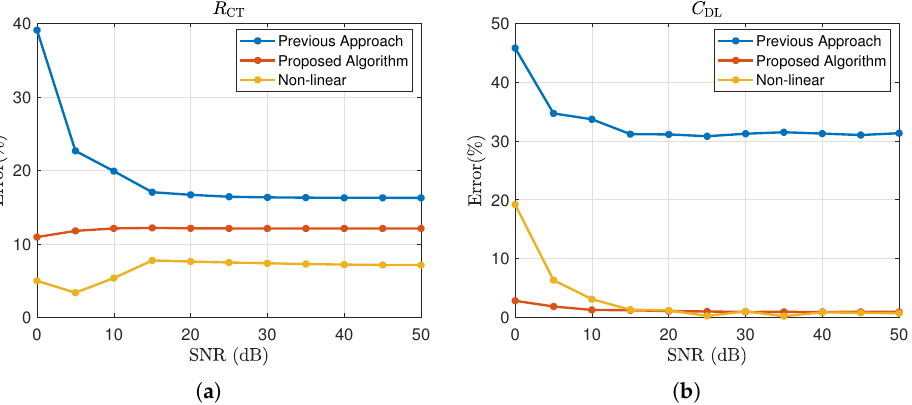
Figure 8. Parameter estimation of the CT Arc. Blue line shows the % error in parameters estimation using previous approach. % error in parameters estimation using the proposed approach and non- linear approach is shown in red and yellow. ( a ) Charge transfer (CT) resistance. ( b ) Double-layer (DT)